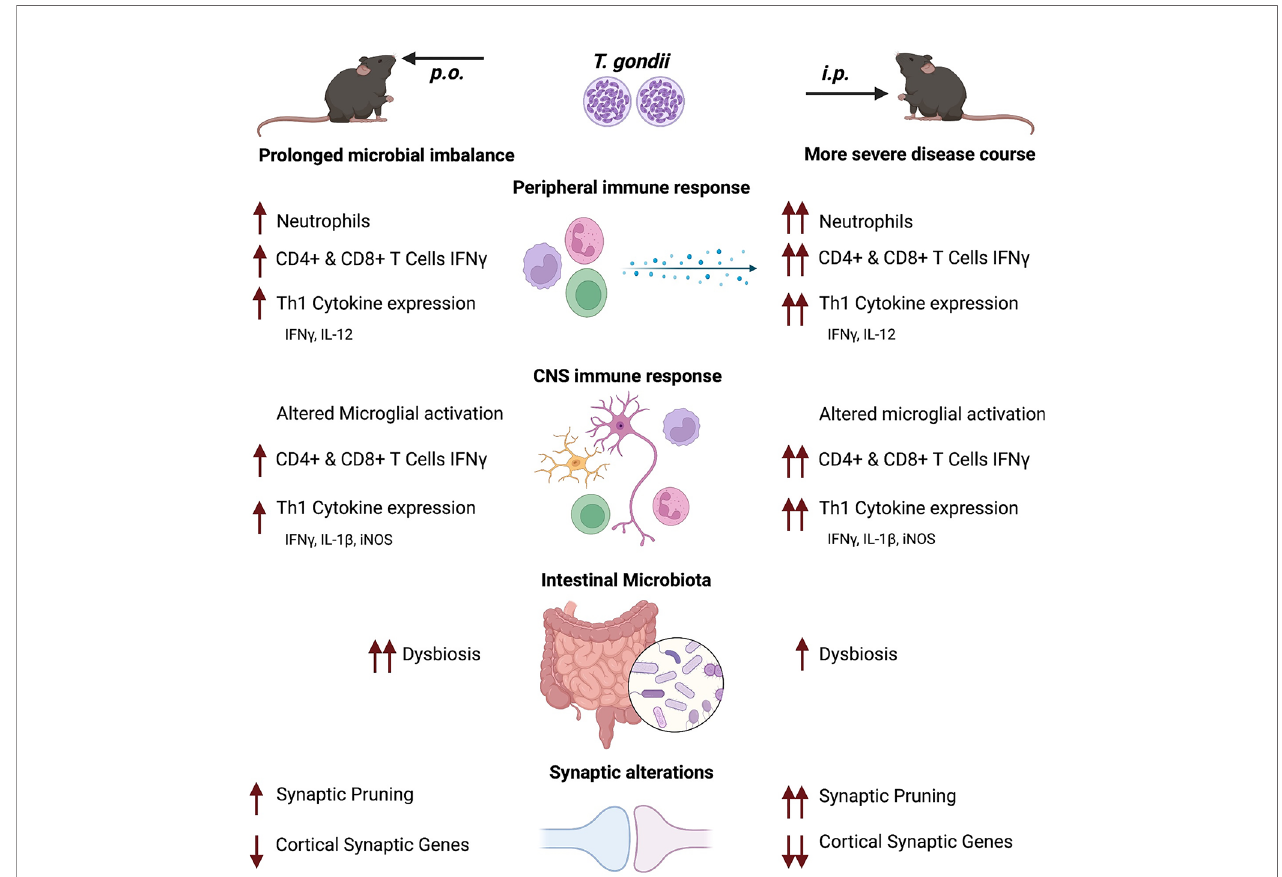
FIGURE 7 | Overview of the T. gondii infection disease course after p.o. and i.p. challenge. Both oral ( p.o. ) or intraperitoneal ( i.p. ) infection with the parasite T. gondii is followed by a robust peripheral immune response characterized by recruitment of myeloid cells, initiation of the Th1 immune response (IL-12 and IFN g production) and activation of effector T cells. After dissemination, the parasites reach the brain where they differentiate into cysts, causing persistent chronic neuroin fl ammation. The observed in fl ammation is characterized by prolonged microglia activation, enhanced synaptic pruning activity and alterations to neural signaling via synaptic alterations. Upon i.p. challenge of mice a more severe disease course is established, with an increased weight loss, higher parasite burden and myeloid cell recruitment as well as a stronger IFN g production by T cells. IFN g , crucial to parasite control, is produced more by T cells after i.p. infection, which is associated with stronger alteration in synaptic marker expression especially in the cortex. T. gondii infection disrupts the intestinal microbiome upon infection. I.p. infection leads to strong shifts in the microbial composition but is less pronounced than the shifts observed upon p.o. infection. This is further exempli fi ed by a loss in microbial diversity of p.o. challenged mice that persists well beyond parasite clearance from the